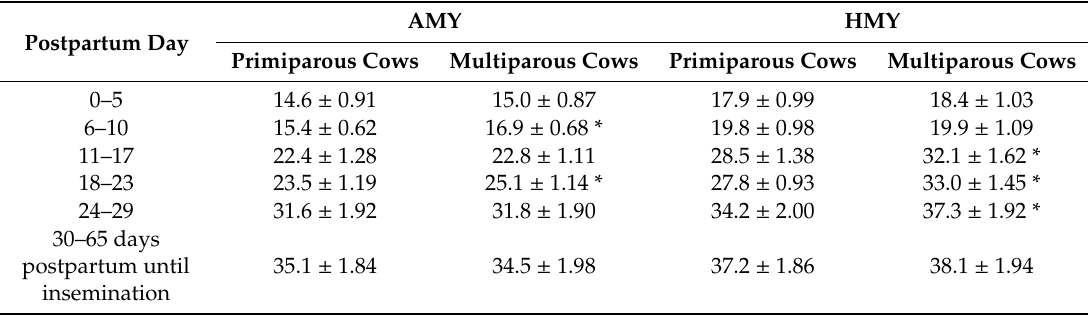
Table 2. The milk yield of cows in the postpartum period until insemination. AMY—average milk yield; HMY—highest milk yield. *—average values of AMY or HMY between primiparous and multiparous cows are statistically significantly different at p < 0.05.